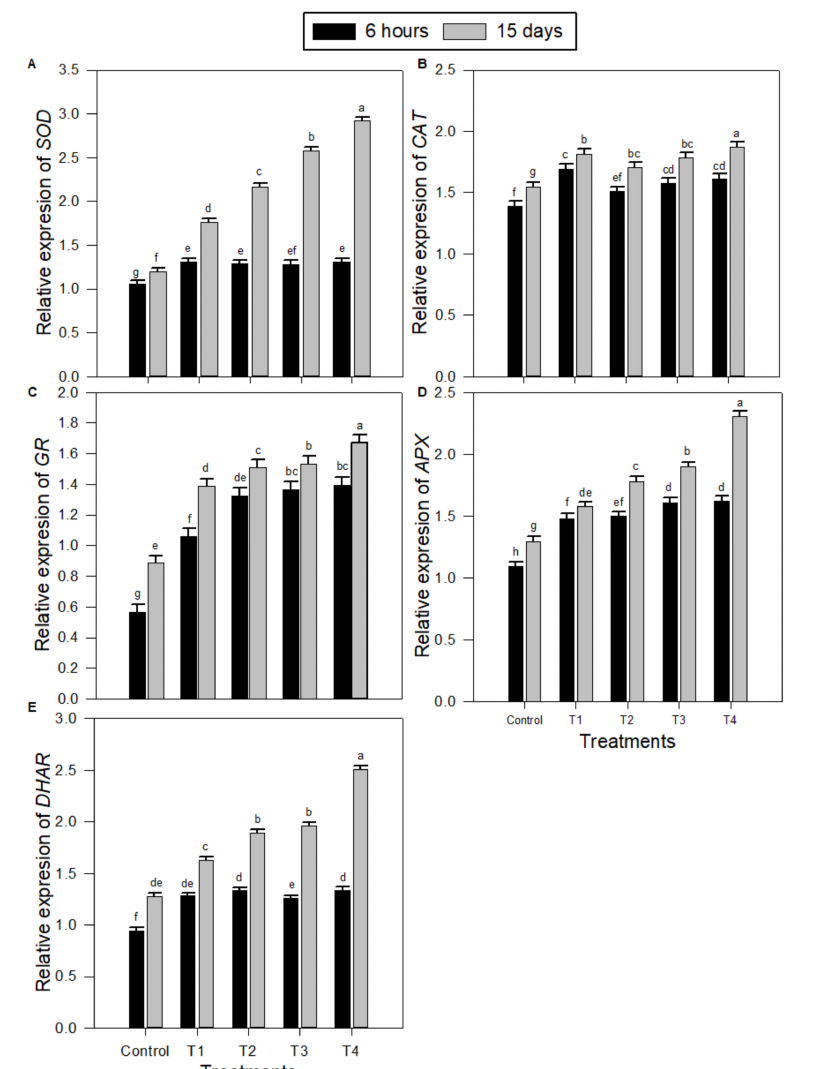
Figure 4. Transcript levels of antioxidant enzymes encoding genes in peanut seedlings under salinity stress combined with different exogenous melatonin treatments after 6 h and 15 days. ( A ) Superoxide dismutase ( SOD ), ( B ) catalase ( CAT ), ( C ) glutathione reductase ( GR ), ( D ) peroxidase ( APX ), and ( E ) dehydroascorbate reductase ( DHAR ). Transcript levels were quantified by qPCR and normalized against actin and GAPDH transcript levels. qPCR experiments were repeated three times with two technical replicates each. The bars labelled with different letters are significantly different. The significant difference marked by different letters was calculated using the Student’s t -test and further analyzed with the Fisher LSD test, at p ≤ 0.05. The legends are as follows: Control: 0 NaCl + 0 MT, T1: 150 mM NaCl + 0 MT, T2: 150 mM NaCl + 50 µ M MT, T3: 150 mM NaCl + 100 µ M MT, T4: 150 mM NaCl + 150 µ M